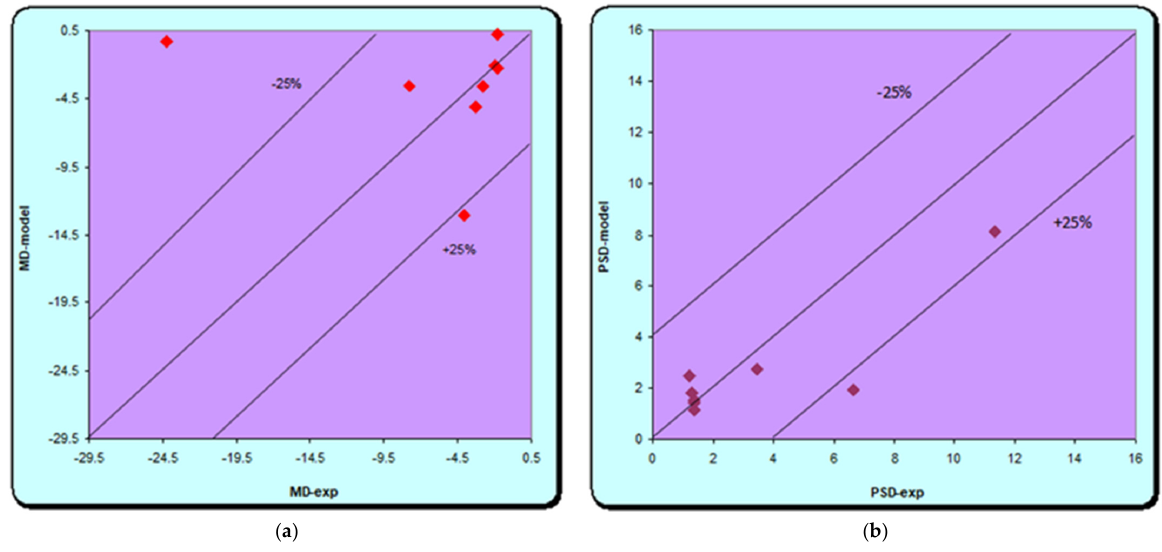
Figure 5. Comparison of experimental results with those provided by the ANN network (21:35:4) in the validation stage ( a ) (MD-experimental), ( b ) (experimental PSD). The positioning of the points near the center line indicates a very good correlation.